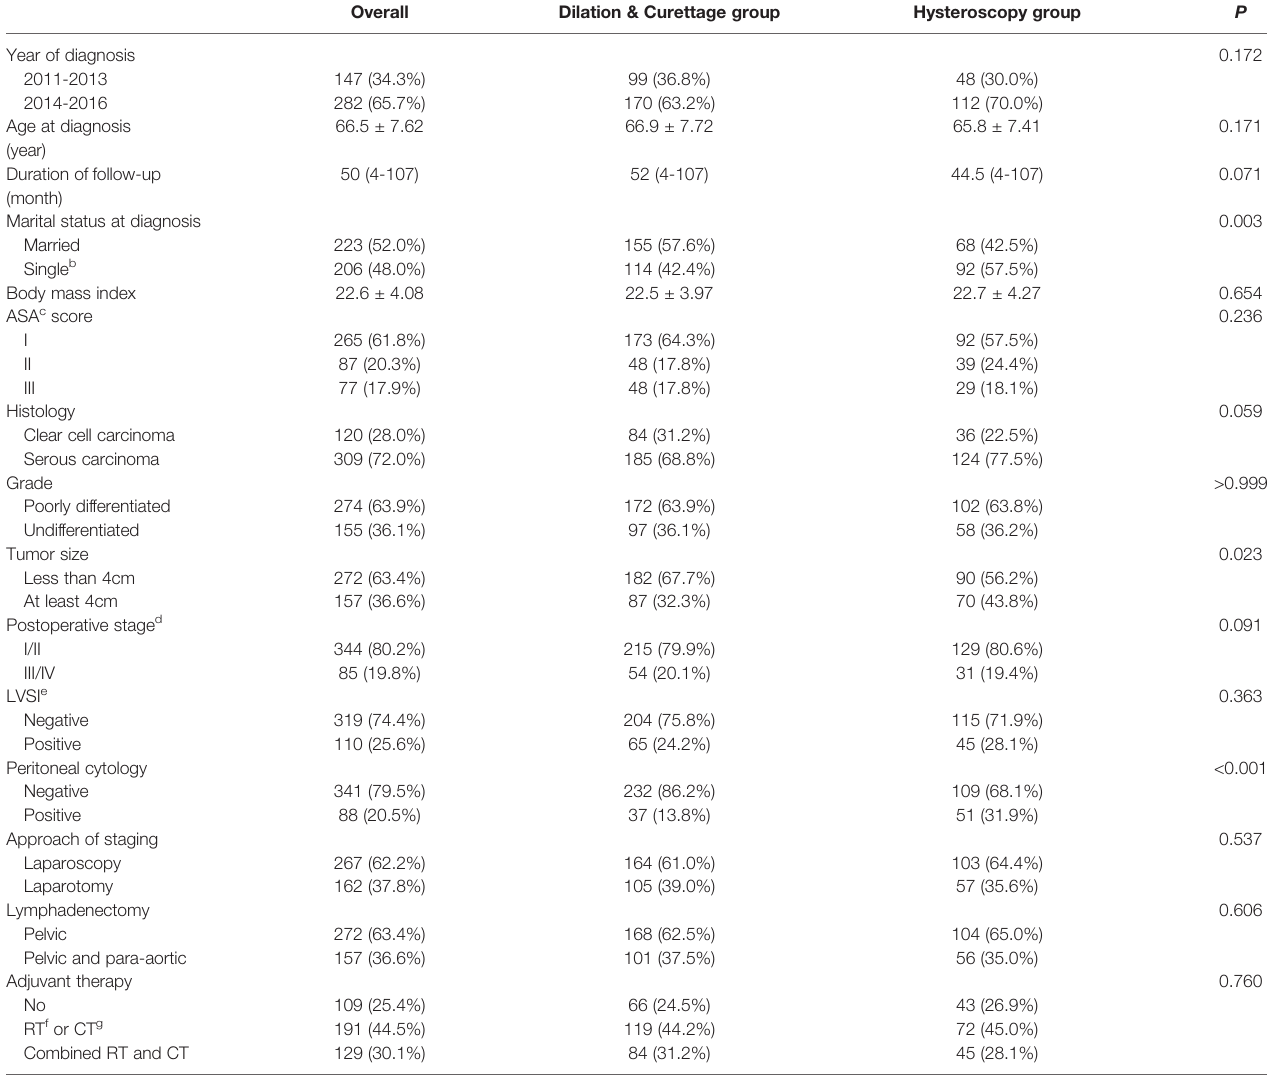
TABLE 1 | Characteristics of the study cohort a